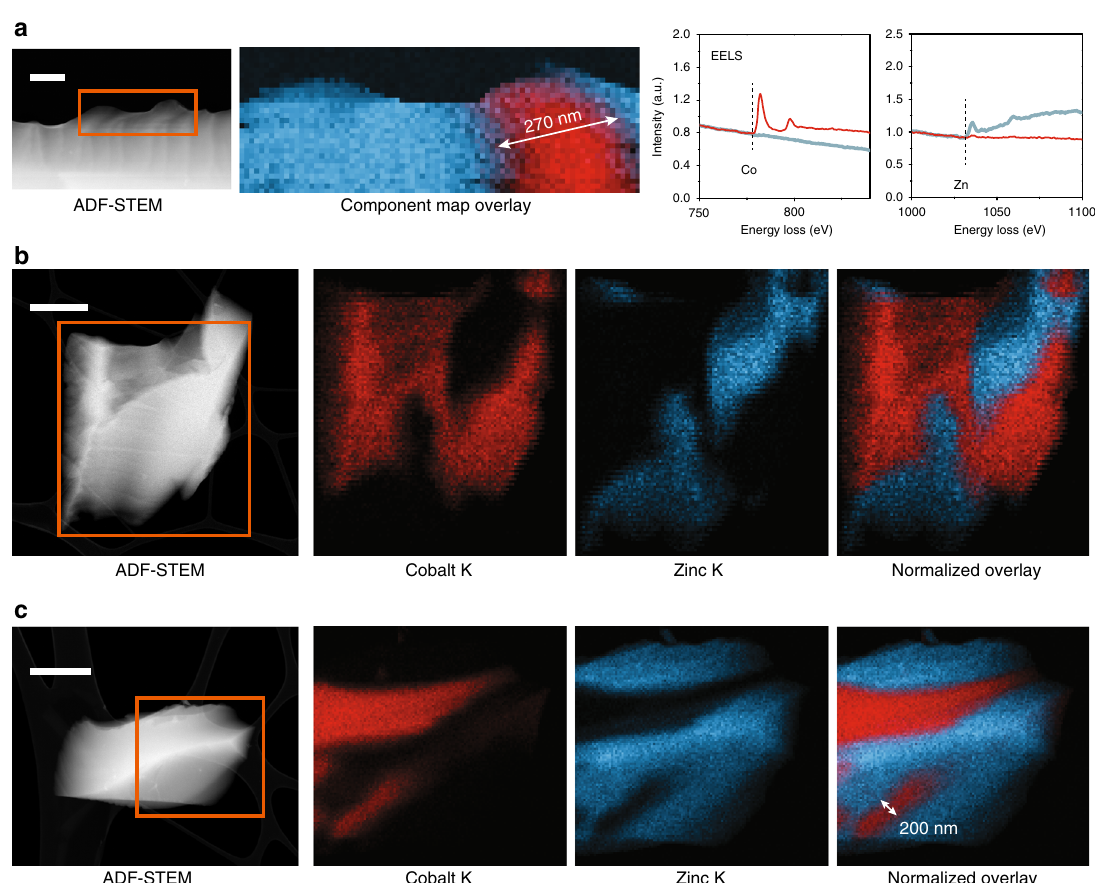
Fig. 4 Chemical mapping of domain structures in (ZIF-4-Co) 0.5 (ZIF-62) 0.5 . a ADF-STEM image and corresponding EELS analysis. Independent component analysis was carried out to separate Co and Zn signals and plotted as a component map overlay (the spectral signals are shown on the right). Scale bar is 250 nm. b ADF-STEM image and corresponding X-ray EDS mapping for a second glass particle. Scale bar is 1 μ m. c ADF-STEM image and corresponding X- ray EDS mapping for a third glass particle. The orange boxes highlight the regions analysed for chemical mapping. Scale bar is 1 μ